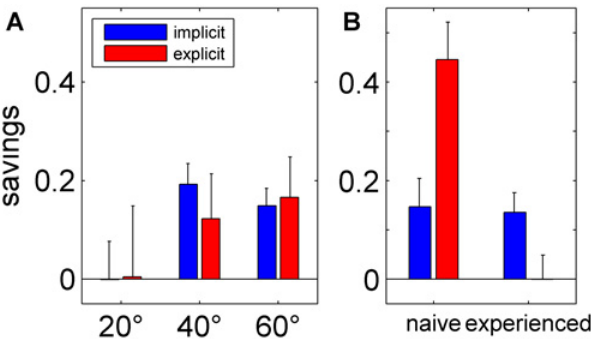
Fig 7. Savings. Mean savings for the implicit (blue) and explicit (red) group for all three perturbation sizes (20°, 40° and 60°) (A) as well as for na ï ve adaptation, i.e. the first rotation size of the experimental protocol, and experienced adaptation, i.e. the second and third rotation sizes (B). For the three rotation sizes statistical analysis revealed no significant effects (all p > 0.05). An analysis of the na ï ve and experienced condition yielded significant effects of Group (p < 0.05), Condition (p < 0.05) and Group × Condition (p <